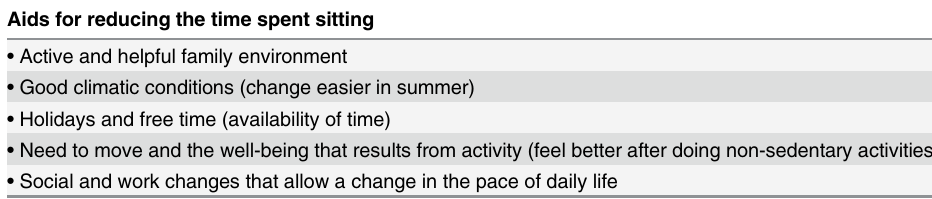
Table 4. Main facilitators to reduce sitting time. Aids for reducing the time spent